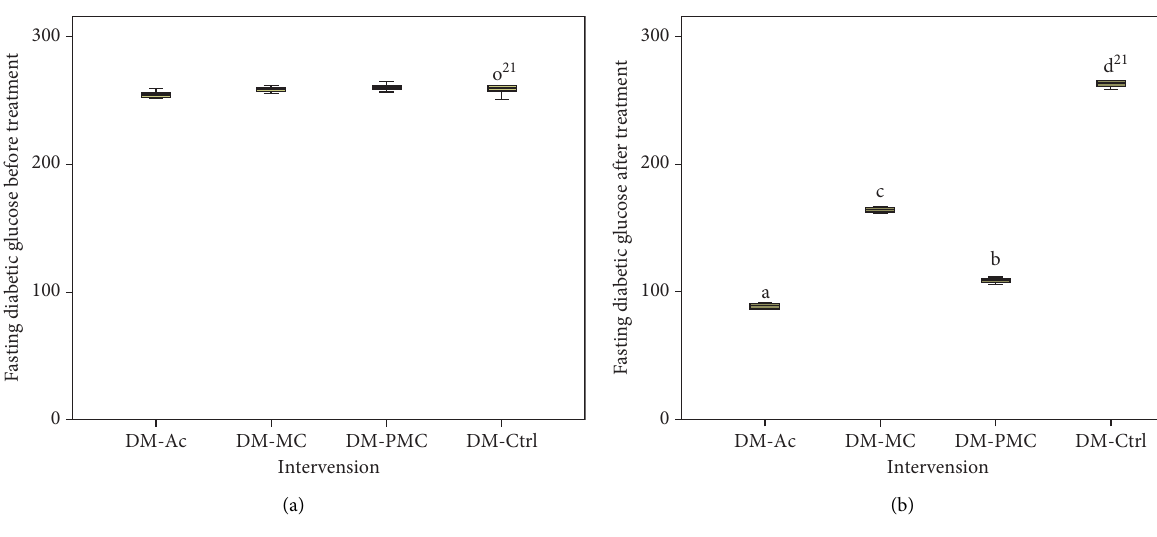
Figure 2: Fasting diabetic glucose: (a) before treatment; (b) after